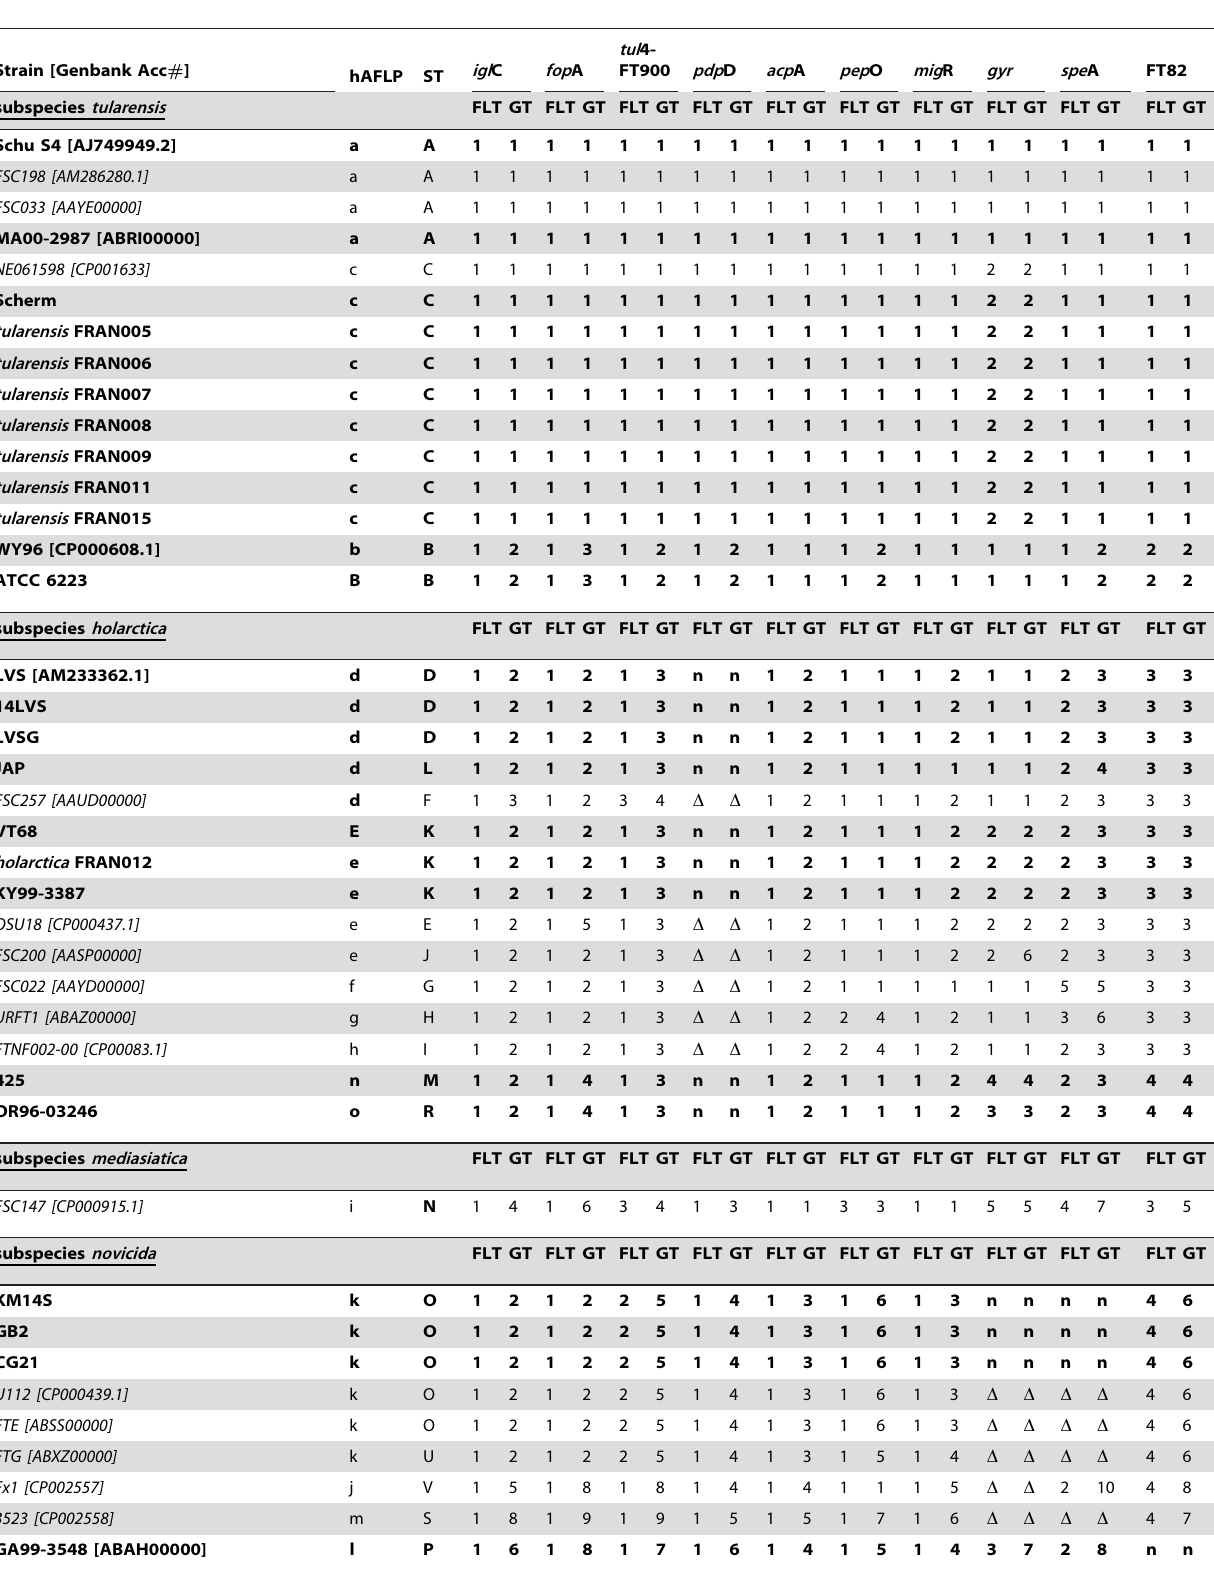
Table 2. hAFLP types and Sequence Types (STs) of Ft strains and Ft near neighbor species DNA (shown in bold) and by in silico analysis of WGS (shown in